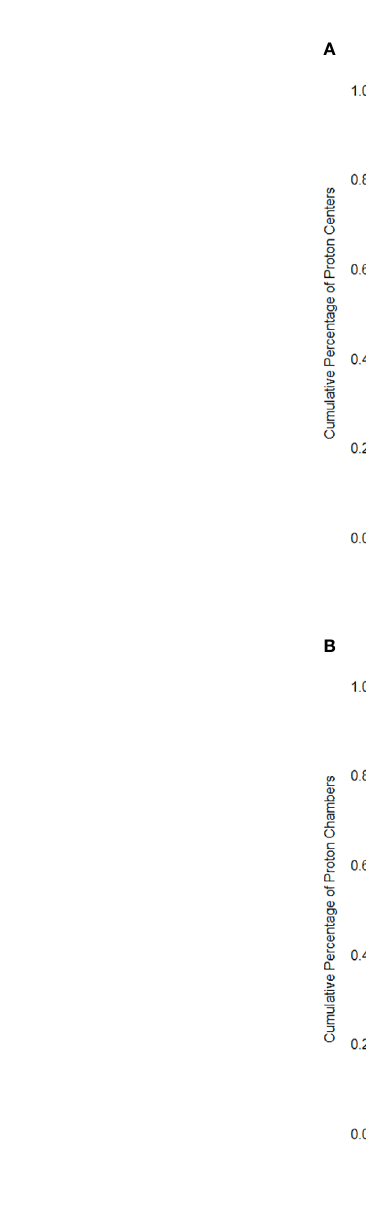
FIGURE 1 | Lorenz curves for PT centers (A) and chambers (B) by country and